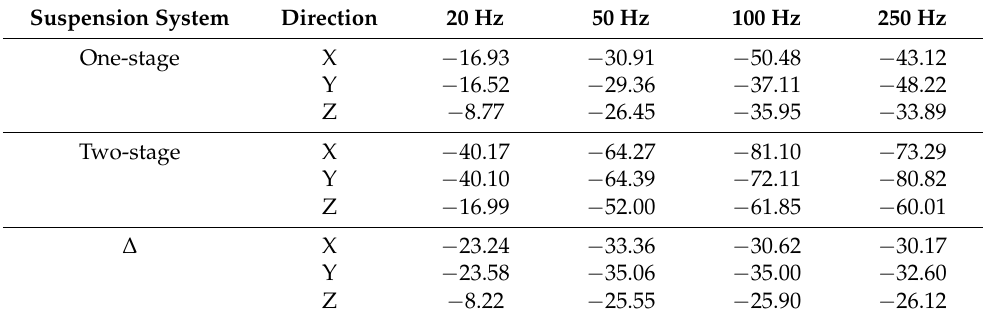
Table 1. The values of the acceleration transmissibility at some typical frequencies (in dB). Suspension